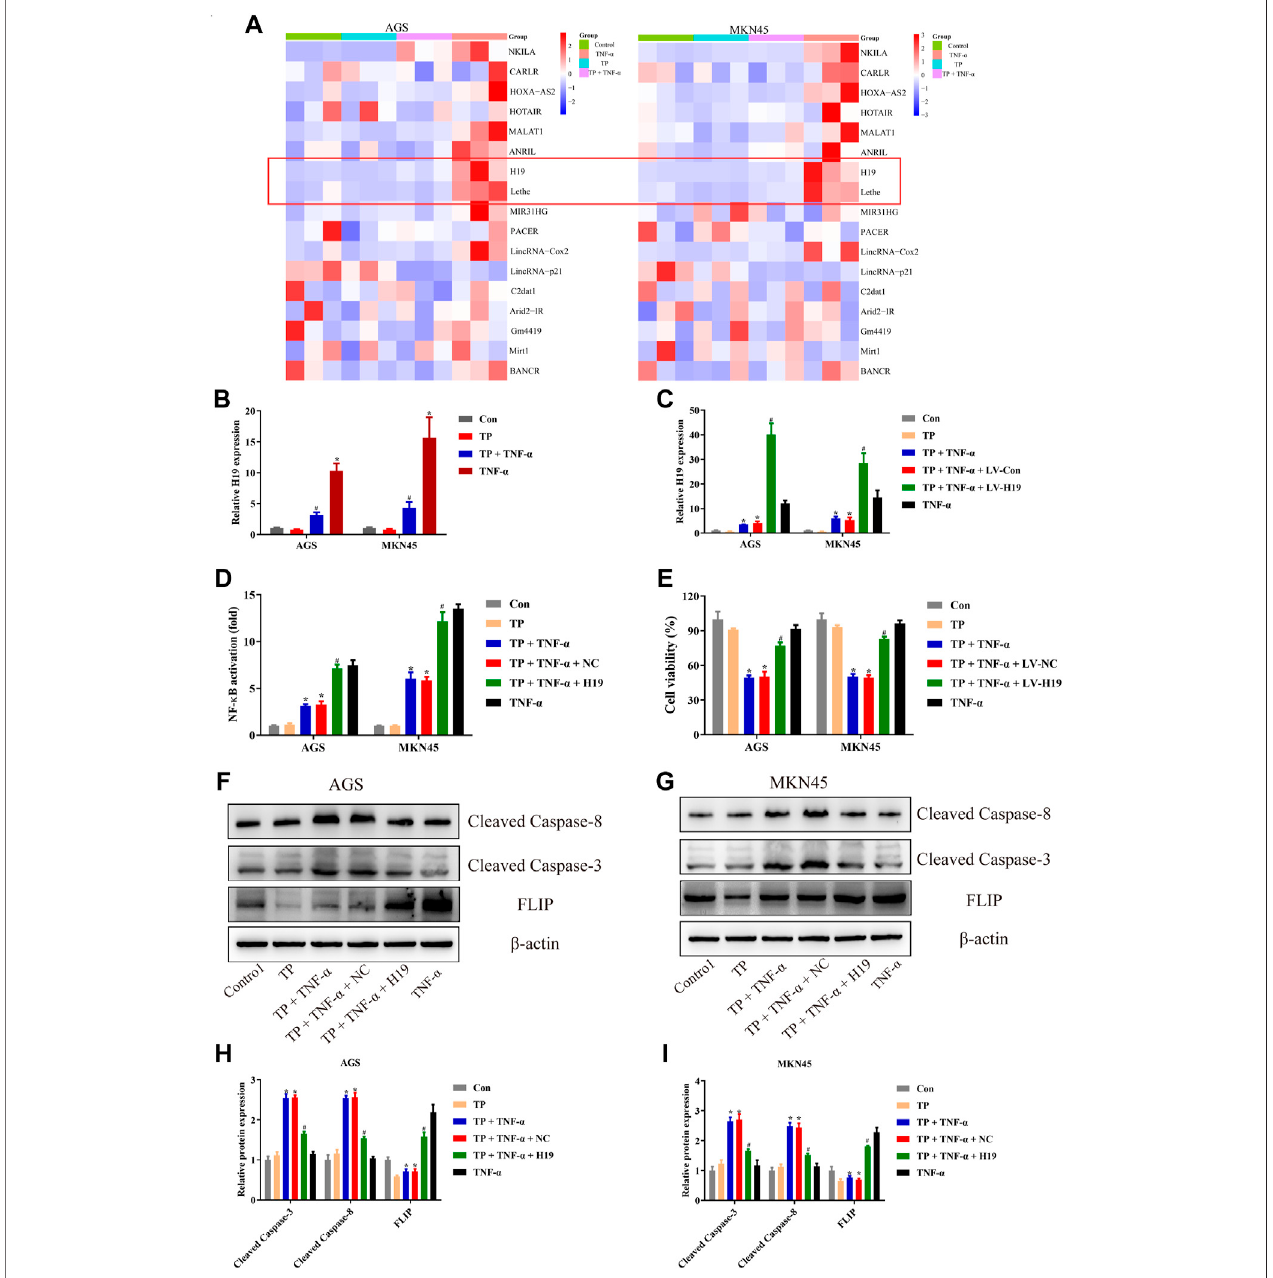
FIGURE4| LncRNAH19actedastheupstreamcomponentoftheNF- κ BpathwayinTP/TNF- α – stimulatedAGSandMKN45cells. (A) NF- κ B-relatedlncRNAwas detected with qPCR 30 min after TNF- α stimulation. (B) Relative mRNA expression of H19 on cells treated with TP (25 nM) and TNF- α (5 ng/ml) for 24 h. (C) Relative mRNA expression of H19 on cells transfected with a plasmid carrying H19 sequence or its negative control treated with TP (25 nM) and TNF- α (5 ng/ml) for 24 h. (D) RelativeNF- κ BactivityofcellstransfectedwithH19plasmidandtreatedwithTP(25nM)andTNF- α (5ng/ml),30minafterTNF- α treatment. (E) CellviabilityofAGS andMKN45cellstransfectedwithaplasmidcarryingH19sequenceoritsnegativecontrolandtreatedwithTP(25nM)andTNF- α (5ng/ml)for24h. (F – I) Representative western blots and relative intensity of protein bands of cleaved caspase-3, cleaved caspase-8, and FLIP in AGS and MKN45 cells transfected with H19 plasmid and treated with TP (25 nM) and TNF- α (5 ng/ml), 24 h after TNF- α application, with β -actin as the loading control. Results were expressed as mean ± SEM, and statistical analysiswas performed using two-wayANOVA followed by Tukey ’ s multiple comparison test. * ,# p < 0.05 ( n ≥ 3). * p compared withthe control group and # p compared with TP/TNF- α /NC-treated group.